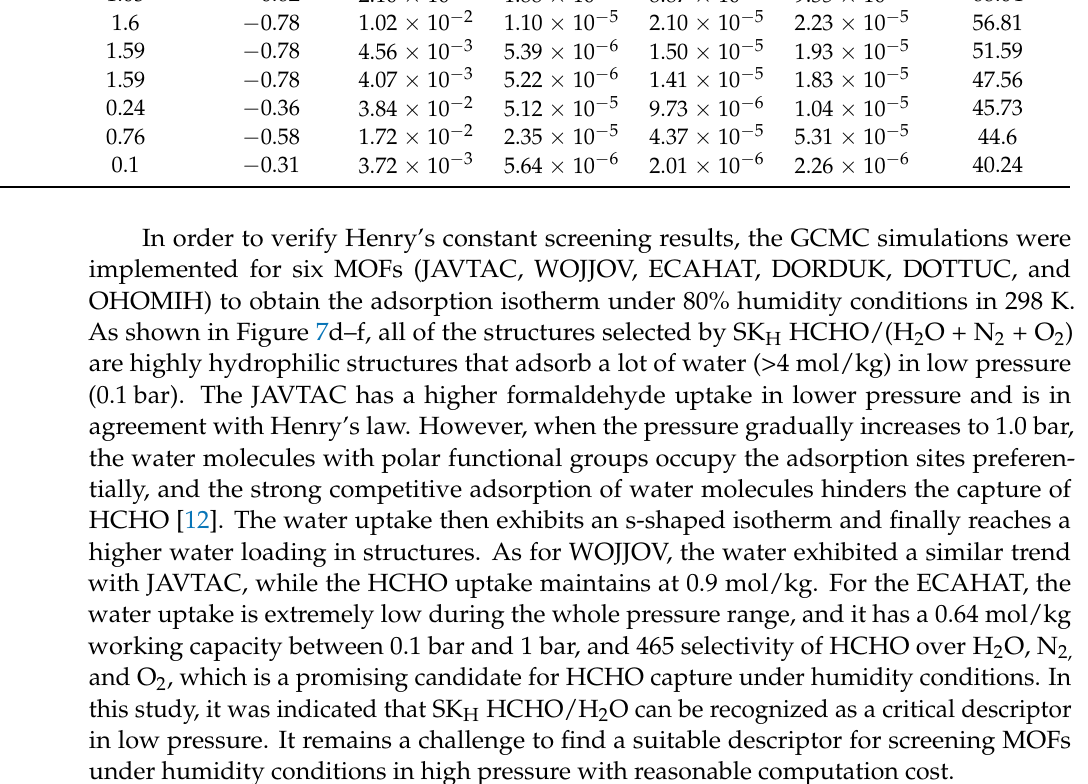
Figure 7. HCHO, H 2 O, N 2 , and O 2 adsorption isotherm of top-performing henry constant selectivity MOFs ( a ) JAVTAC, ( b ) WOJJOV, ( c ) ECAHAT, ( d ) DORDUK, ( e ) DOTTUC, ( f ) OHOMIH for a mix- ture component of HCHO/H 2 O/N 2 /O 2 = 200/3280/77,216/19,304 from GCMC simulation at 298 K. 3. Materials and Methods 3.1. MOFs Database All MOF structures were obtained from the computation-ready, experimental (CoRE) MOF database Version 1.0 [39], which the solvent and disorder structures were removed from Cambridge structural database (CSD) by Chung and co-workers. The struc- ture with density derived electrostatic and chemical (DDEC) [40] charges containing 2932 structures were developed by Nazarian [41]. After removing the structures with zero ac- cessible surface area (ASA), there are 1668 structures to perform formaldehyde capture screening. The ASA, largest cavity diameter (LCD), pore limiting diameter (PLD), and available pore volume (V a ) were computed using the 1.86 Å nitrogen probe in zeo++0.3. Helium void fraction (VF) and Henry’s constant of MOFs toward H 2 O, HCHO, N 2 and O 2 were obtained by the Widom particle insertion method. 3.2. Grand Canonical Monte Carlo CoRE MOFs containing 1668 structures carrying DDEC charges were employed for high-throughput screening. GCMC simulations were implemented to obtain the adsorp- tion performance of these structures in RASPA 2.0. During the screening stage, 4 × 10 4 Monte Carlo cycles were performed to estimate the adsorption isotherms of each MOF, including the initial 2 × 10 4 cycles of equilibration run, and the other 2 × 10 4 cycles of the production run. Four Monte Carlo moves of insertion, deletion, rotation, and translation were implemented with equal probability. Identity change of adsorbate molecules for